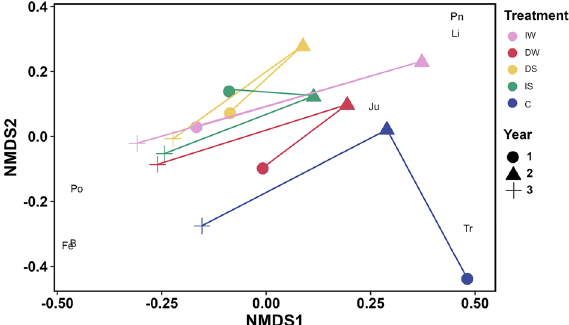
Figure 7. Non-metric multi-dimensional scaling (NMDS) plot of Upper Shore plant community composition averaged % cover from August; n = 3) based on Bray–Curtis dissimilarity matrix. Po Poa annua , Pn Poa angustifolia , Li Linum catharticum , B bare ground, Fe Festuca rubra , Tr Triglochin maritima , Ju Juncus gerardii . Pink: increased water level (IW); red: decreased water level (DW); yellow: decreased salinity (DS); green: increased salinity (IS); blue: control (C). Circle: year 1 (2018); triangle: year 2 (2019); cross: year 3